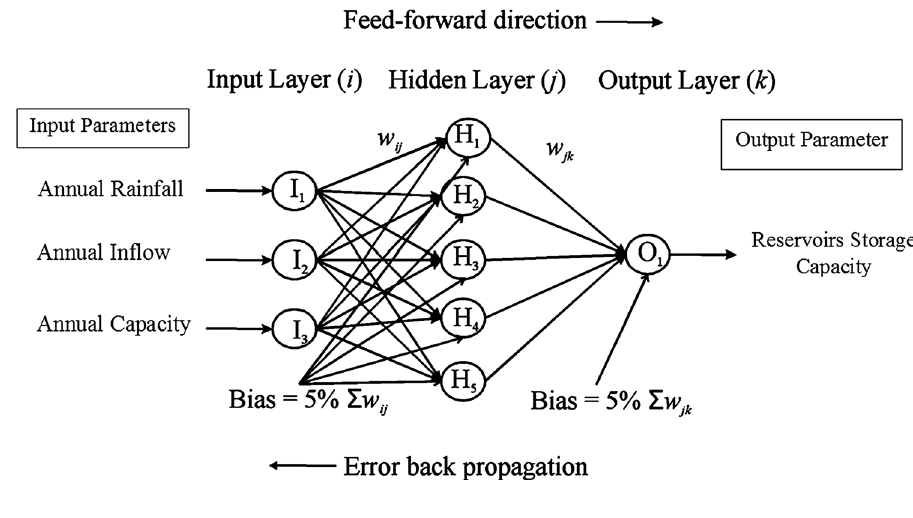
Fig. 8 The neural network architecture used in the present study